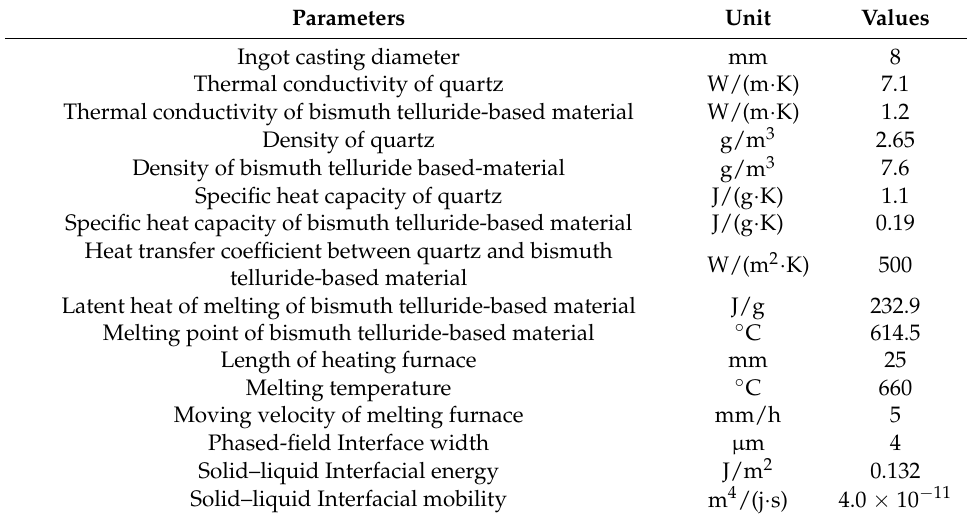
Table 1. Thermophysical parameters and boundary conditions